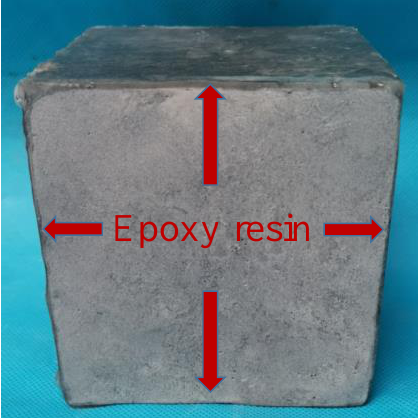
Figure 3. Specimen coated with epoxy resin.